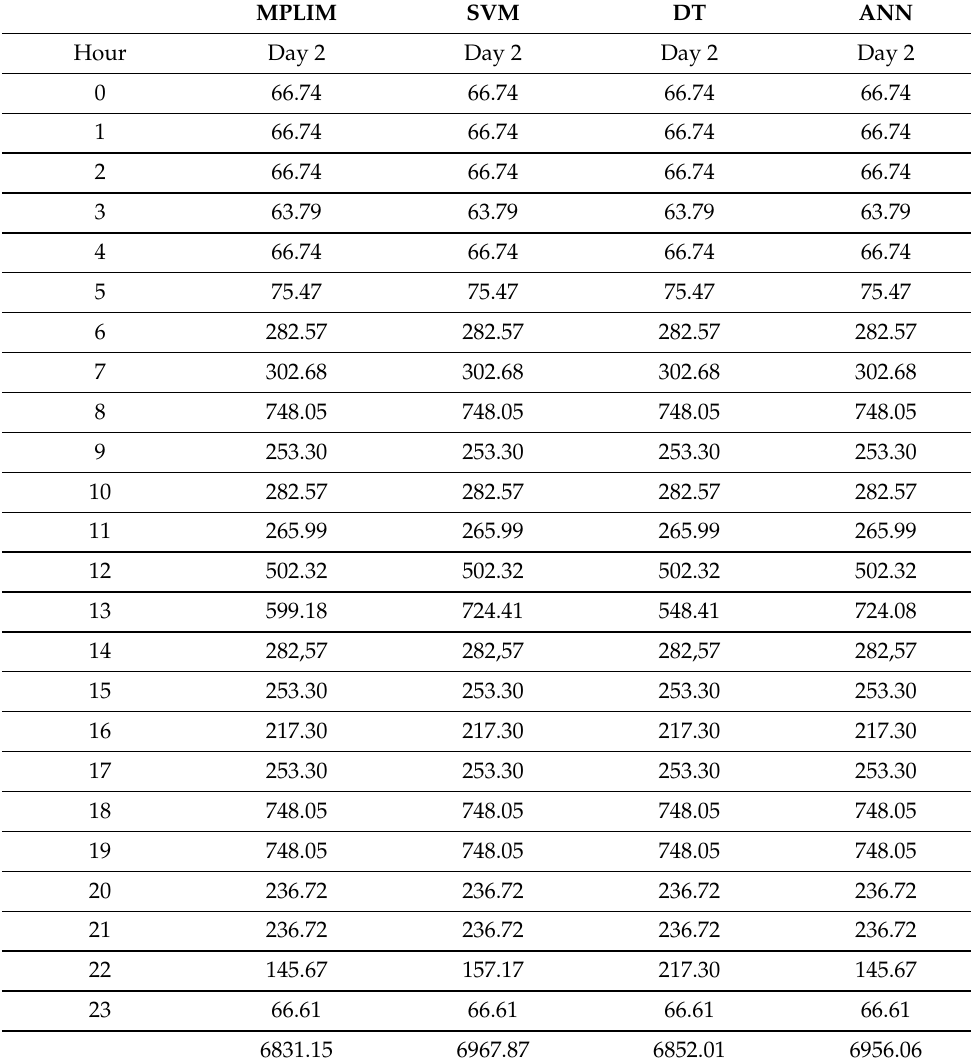
Table 6. Comparison of hourly energy loss results in